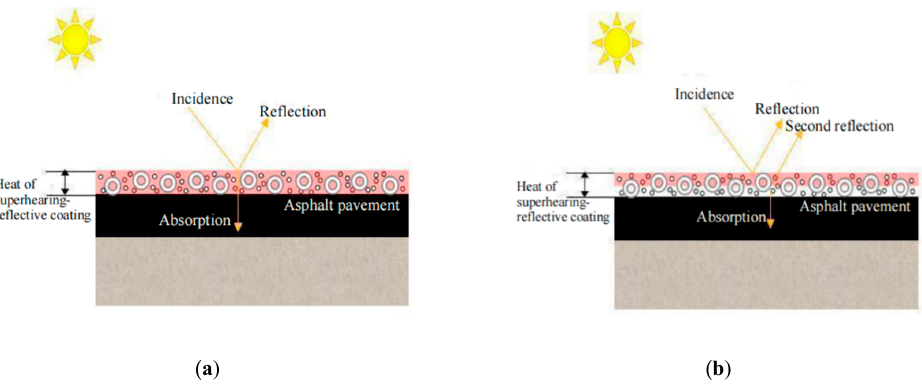
Figure 8. Working principle of coatings with different structures. ( a ) Single-layer coating structure, (b) Double-layer coating structure.